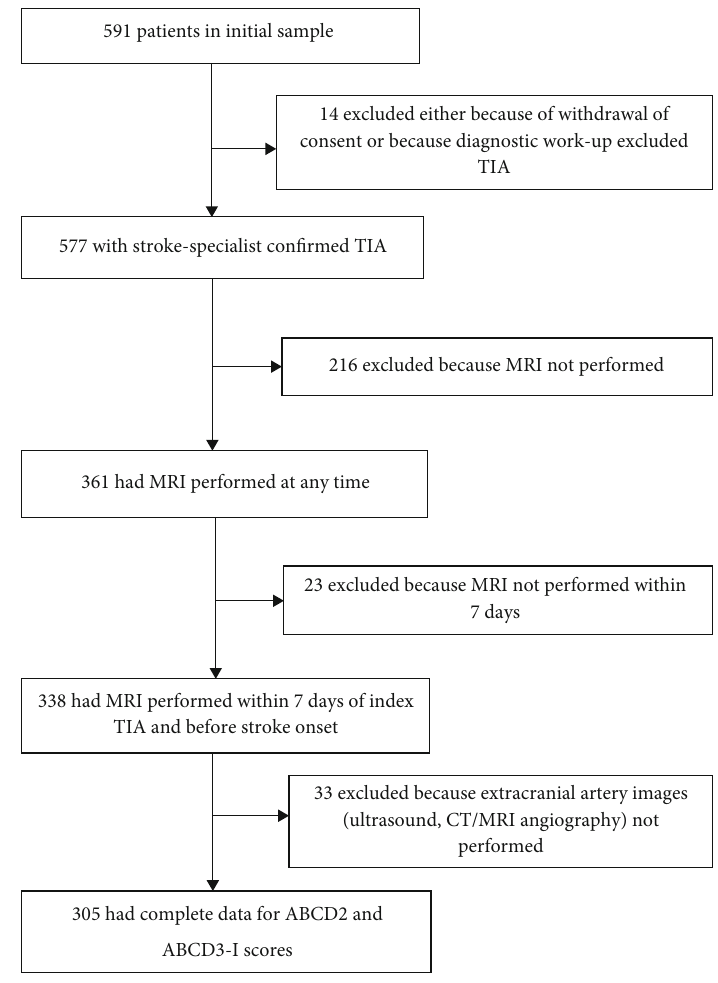
Figure 1: Flow chart of study pro fi